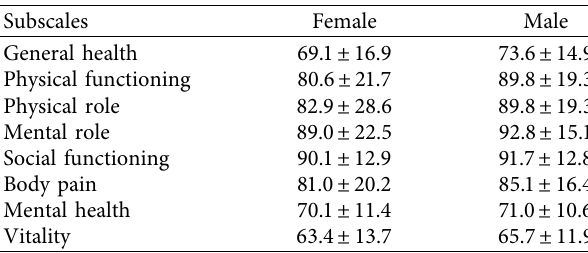
Table 3: Average values of the SF-36 subscale scores previously reported for the Turkish society